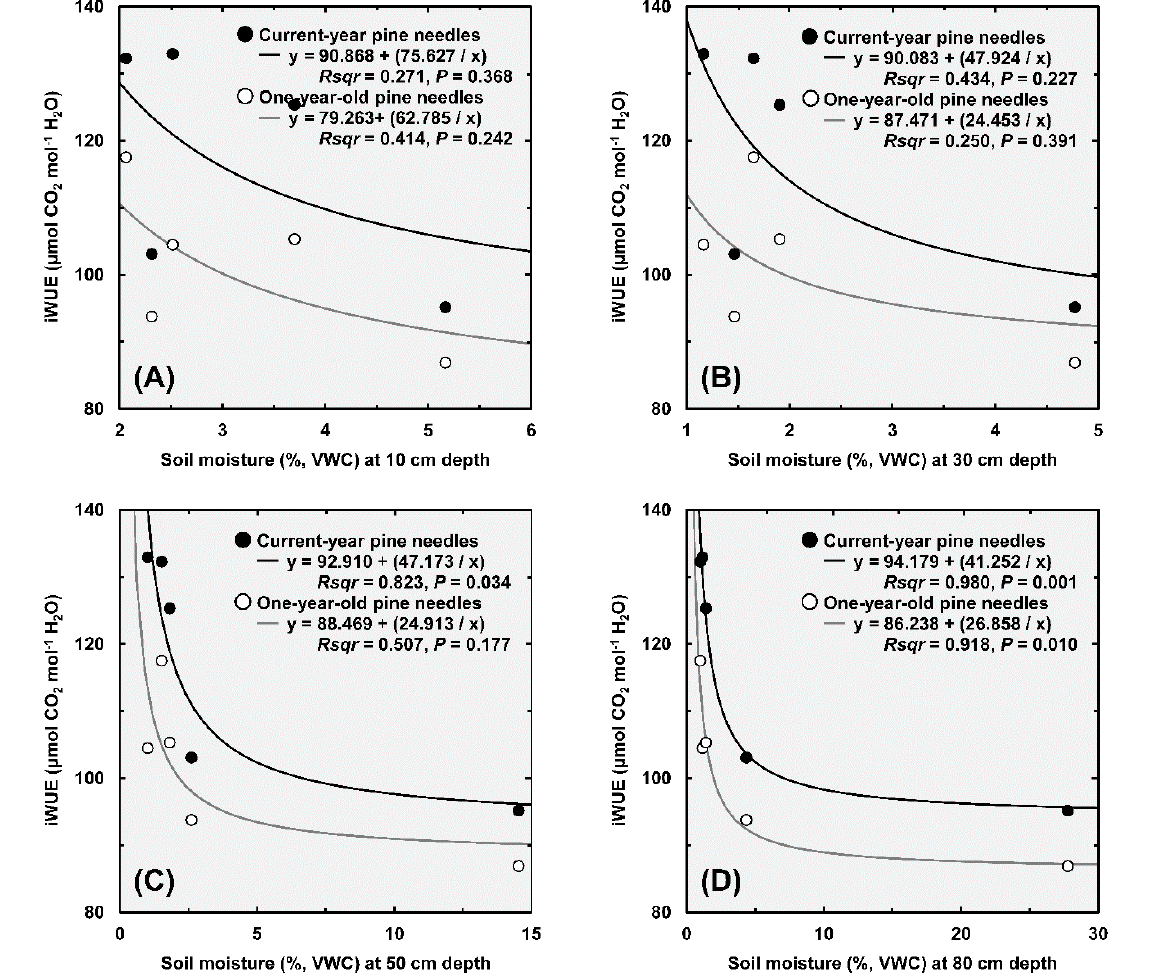
Figure 6. Relationship between iWUE values in Mongolian pine needles and moisture contents at di ff erent soil depths, i.e., 10 ( A ), 30 ( B ), 50 ( C ), and 80 cm ( D ), according to changes in sand dune height.